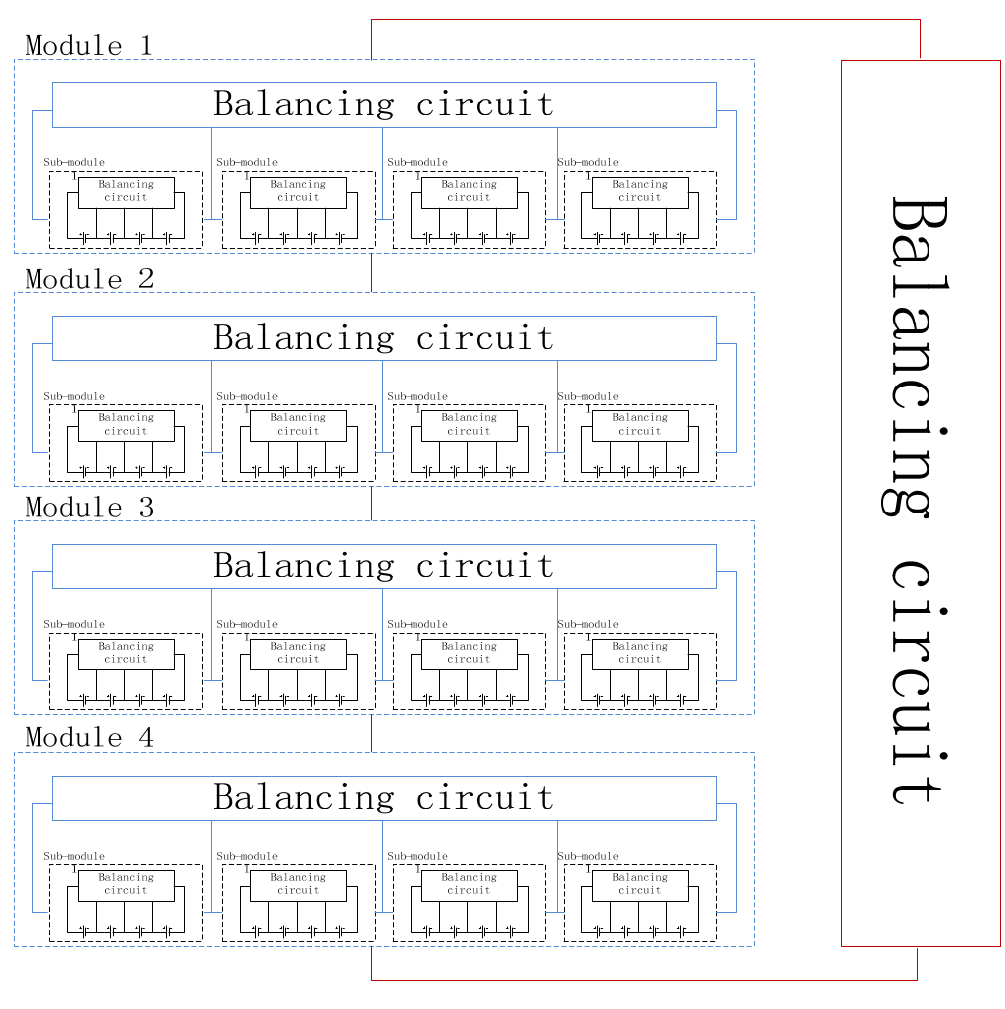
Figure 1. Layered balancing